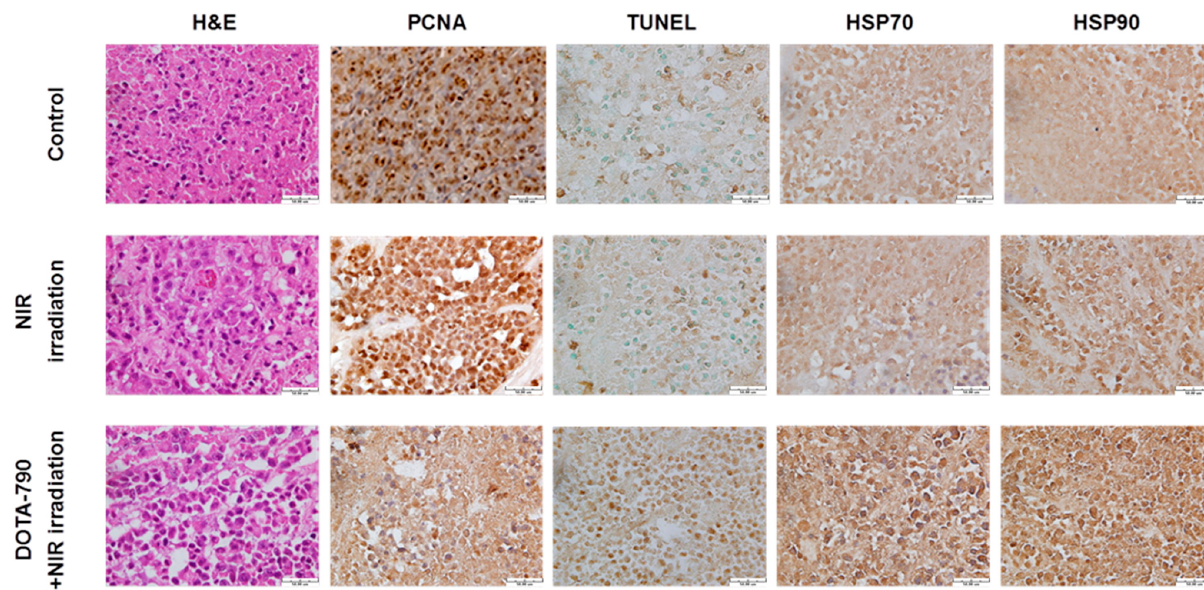
Figure 8. Anti-tumor effect of multi-functional tumor theranostics probes. ( A ) Tumor growth inhibition of photothermal therapy (PTT) combined with targeted radionuclide therapy by 177 Lu-DOTA-NIR790 ( n = 6 per group) ( B ) body weight changes, and ( C ) Representative mice treated with 177 Lu-DOTA-NIR790 and NIR irradiation for 5 min were photographed. The scale bar is 10 mm.